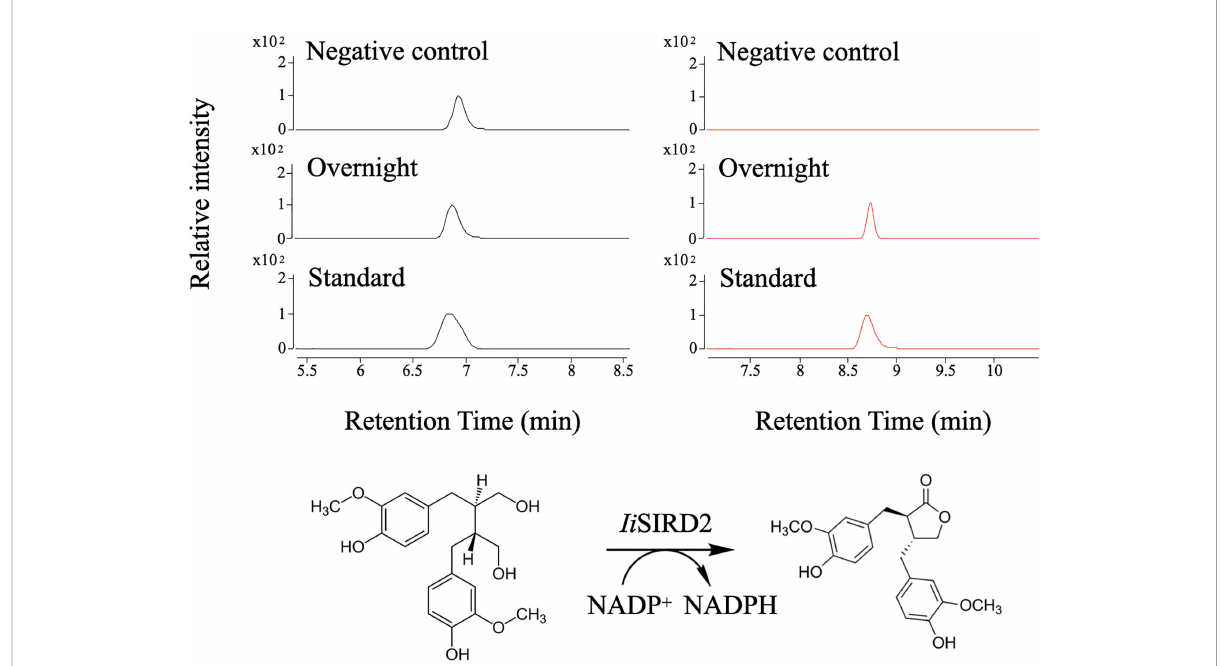
FIGURE 2 Biochemical assays for Ii SIRD2 function. Matairesinol was detected in the enzyme assay mixture, proving that Ii SIRD2 catalyzes an NADP + - dependent reaction of converting secoisolariciresinol into